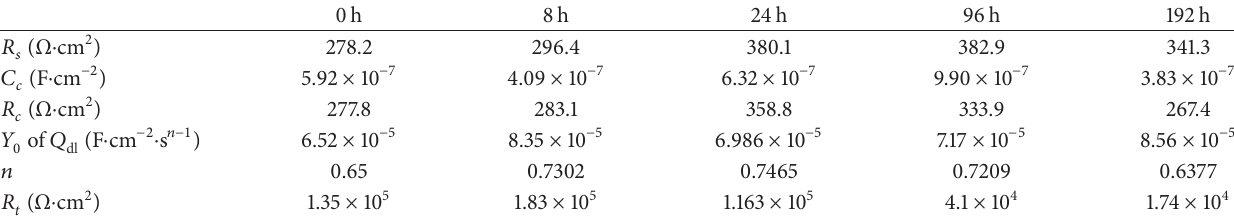
Table 5: Impedance value of epoxy antirust painted samples with scratch calculated from EIS